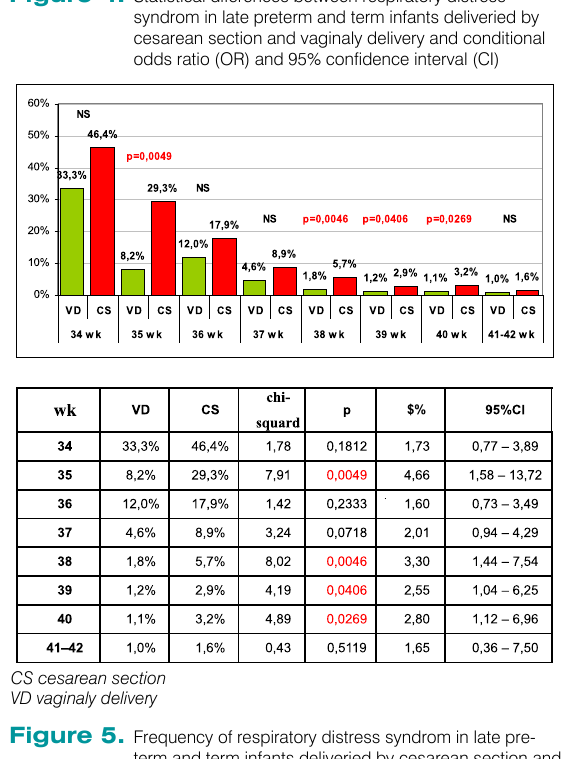
Figure 2. Apgar score late preterm and term infants delivered by cesarean section and vaginaly